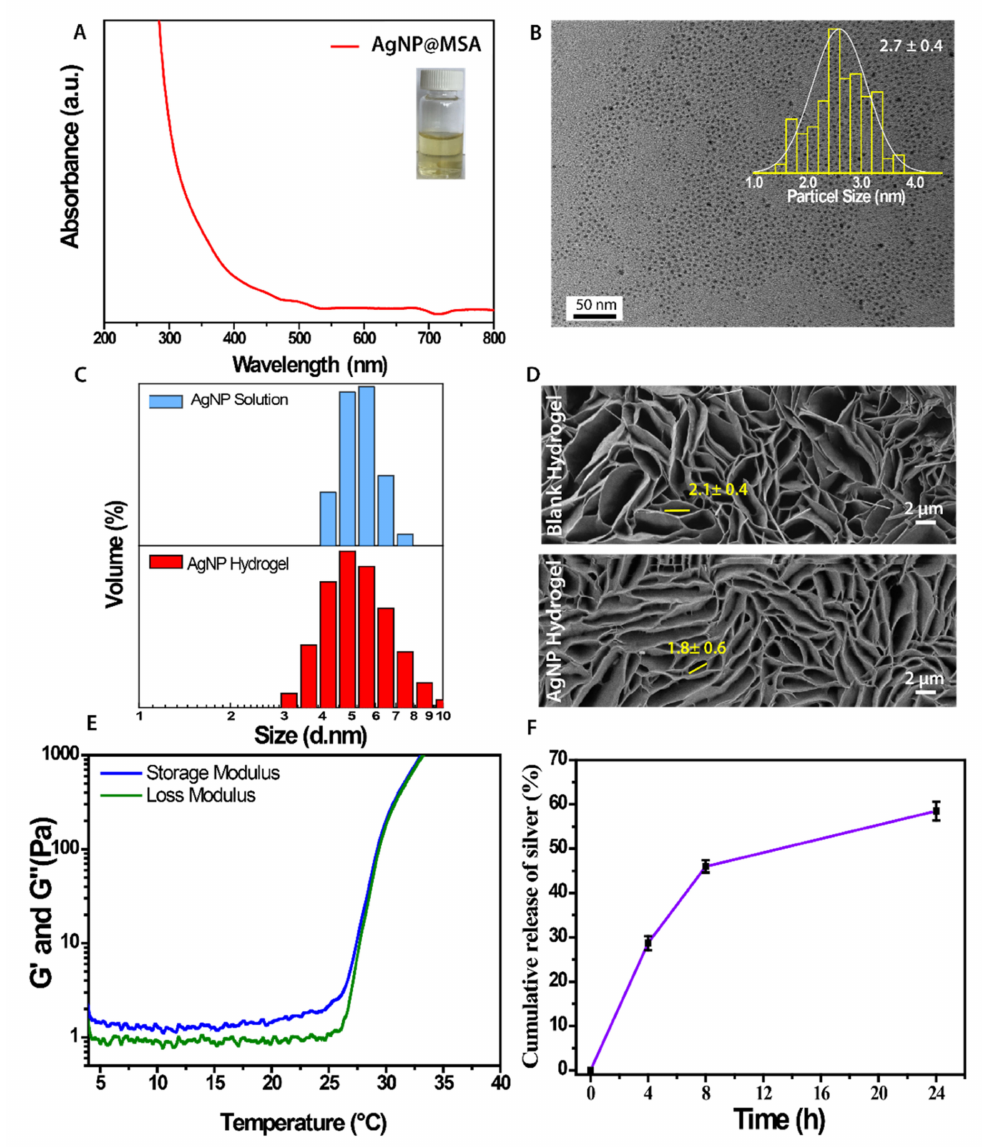
Figure 1. Physicochemical characterizations of AgNP hydrogel. ( A ) UV-vis spectrum of MSA_AgNP with respective solution colour. ( B ) TEM micrographs of AgNPs in water with corresponding size distribution. ( C ) The hydrodynamic diameter of both AgNPs in solution and hydrogel. ( D ) microstructure of both AgNP hydrogel and blank analyzed by SEM. ( E ) AgNP hydrogel gelation point in response to the surrounding temperature. ( F ) In vitro cumulative release of silver from the